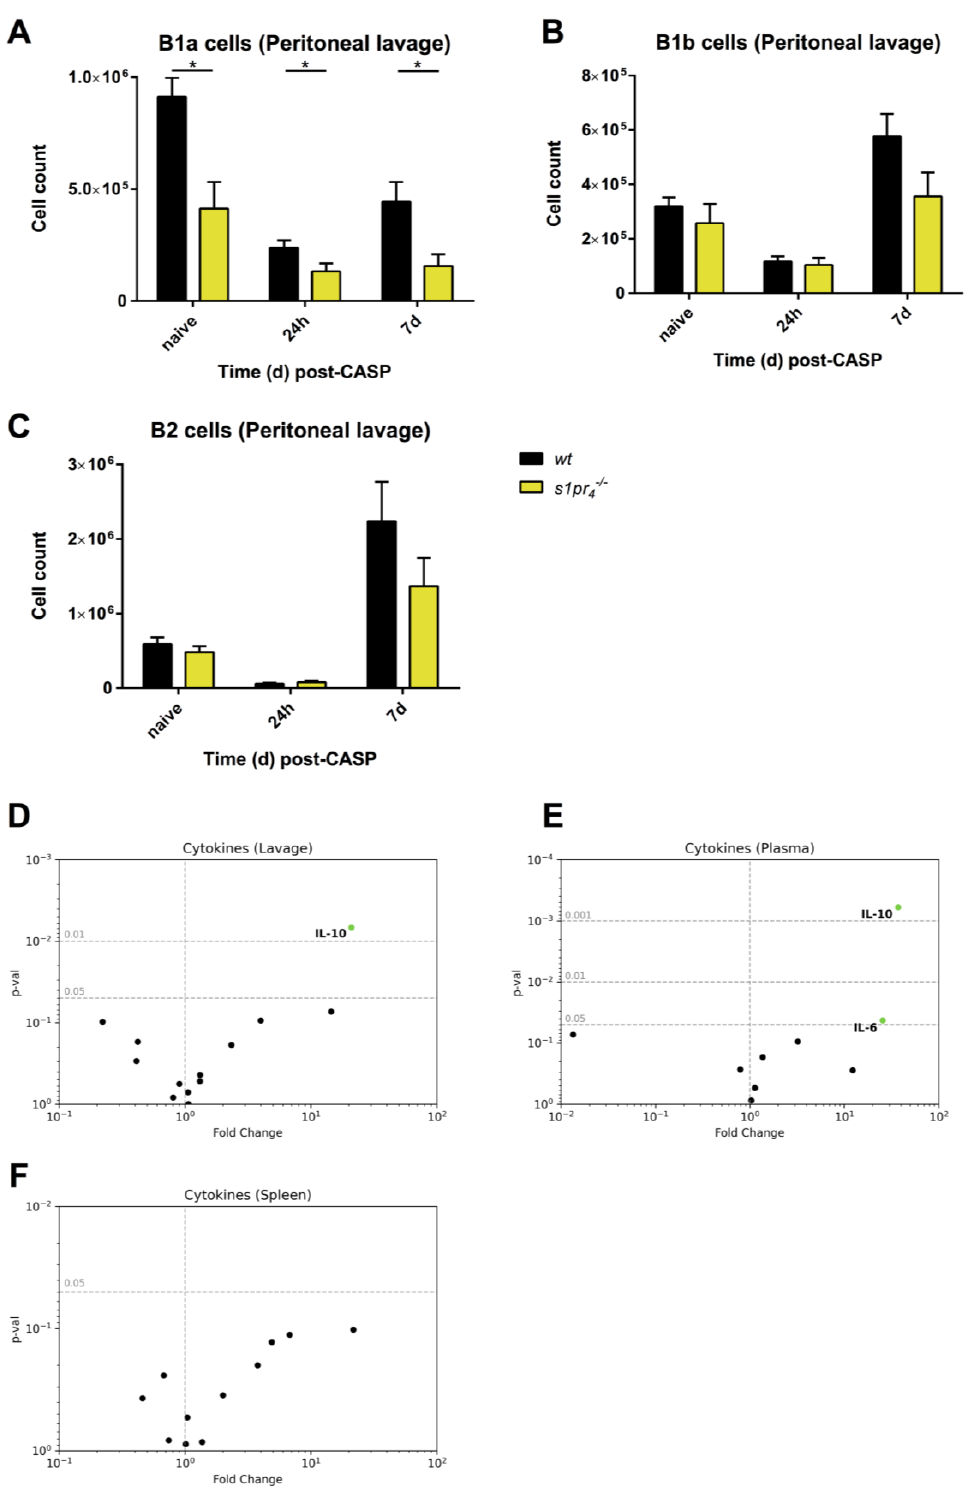
Figure 7. Influence of S1P 4 expression on the composition of peritoneal B cell populations and cytokine levels in a murine model of polymicrobial abdominal sepsis. Polymicrobial abdominal sepsis was induced by colon ascendens stent peritonitis (CASP) in wt and s1pr 4 − / − mice. ( A – C ) The number of B1a ( A ), B1b ( B ) , and B2 ( C ) B cells within the peritoneal lavage fluid of naive mice, 24 h and 7 days after induction of CASP. ( D − F ) Measurement of cytokines in the lavage ( D ), plasma ( E ), and spleen ( F ) 24 h after the induction of abdominal sepsis. The fold change of concentrations between wt and s1pr 4 − / − animals was calculated and plotted against the corresponding p -values ( n = 10). Only cytokines that reached significance are labeled. * p <